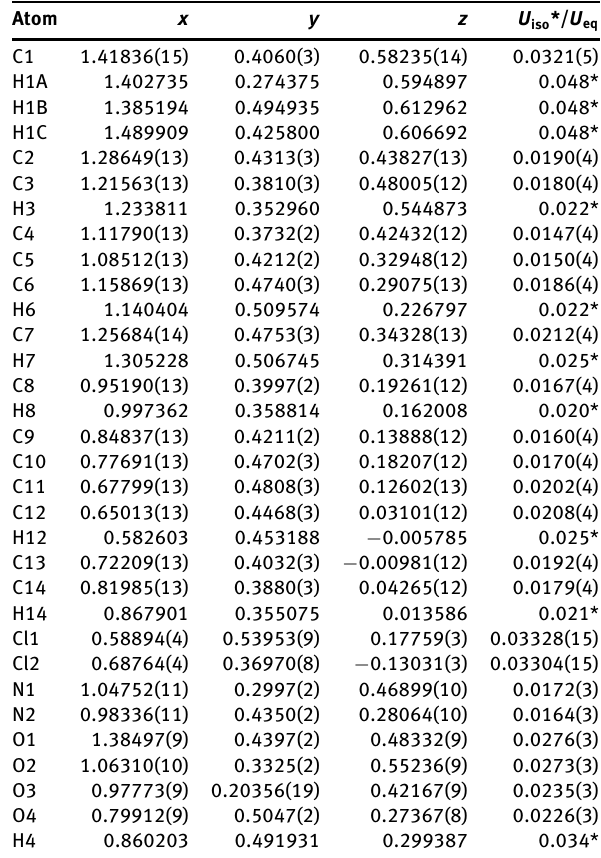
Table 2: Fractional atomic coordinates and isotropic or equivalent isotropic displacement parameters (Å 2